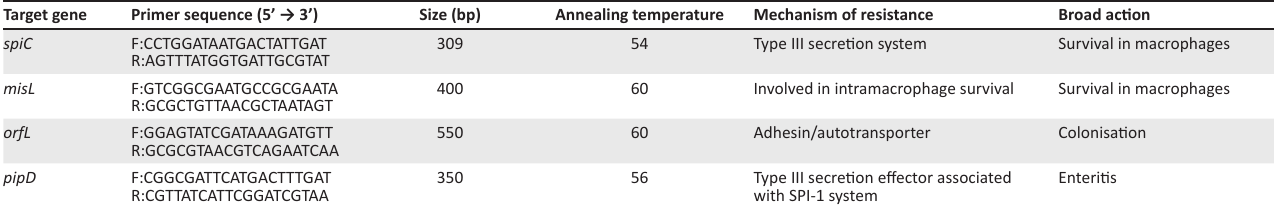
TABLE 2: Primers used to detect virulence genes in Salmonella spp. Target gene